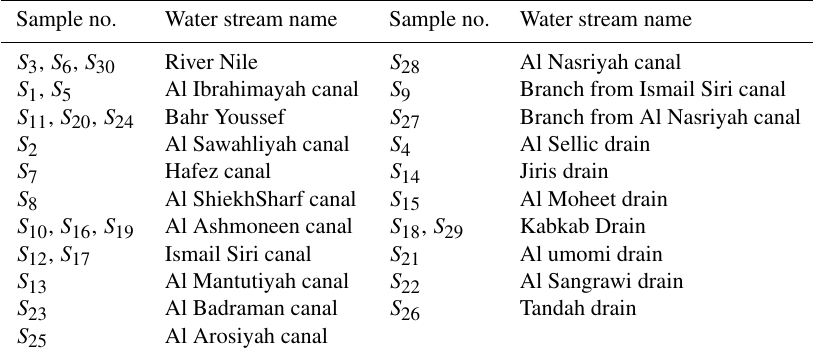
Table 1. Surface water samples and localities.